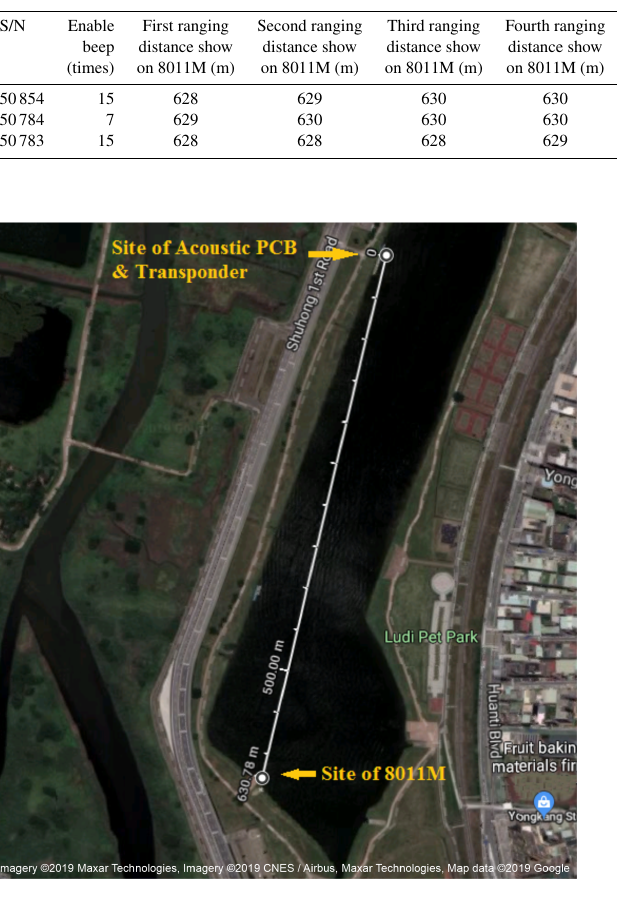
Figure 10. A map of the field test to evaluate the acous- tic transducer, acoustic controller and 8011M (modified from Google Maps, https://www.google.com.tw/maps/@25.0902745,